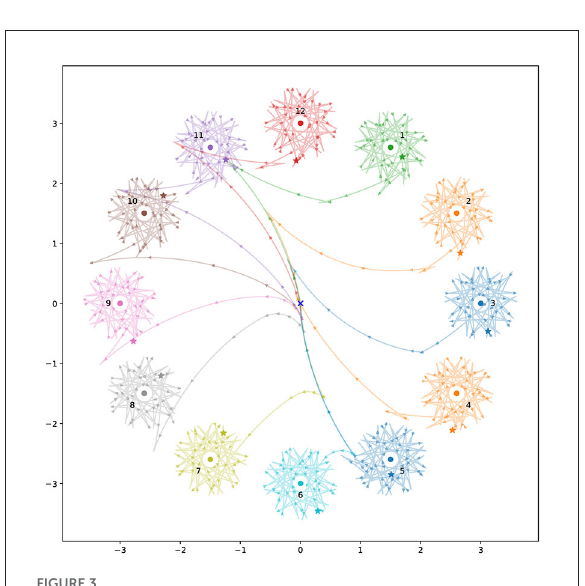
FIGURE3 Spatial trajectories for the best individual from the ancestral population for 12 different light coordinates. The robot always begins at the origin, facing toward positive y (upwards). Stars mark the final position reached during the trial duration used during evolution. The colored circles show the light position for the correspondingly colored trajectory. The triangles along the trajectories point in the direction the robot is facing. They are plotted at uniform time intervals, so more spaced out triangles indicate faster